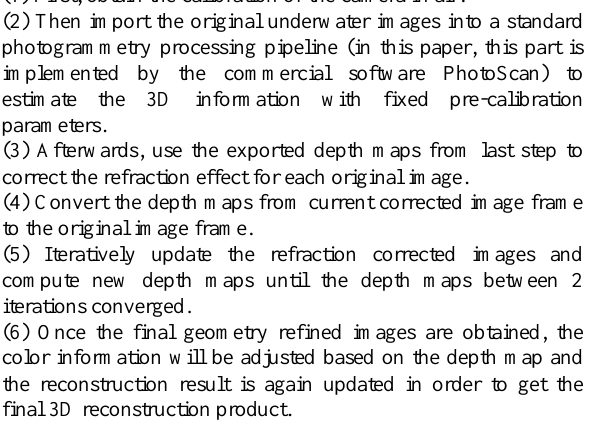
Figure 3. Workflow of the proposed iterative refinement 3D reconstruction